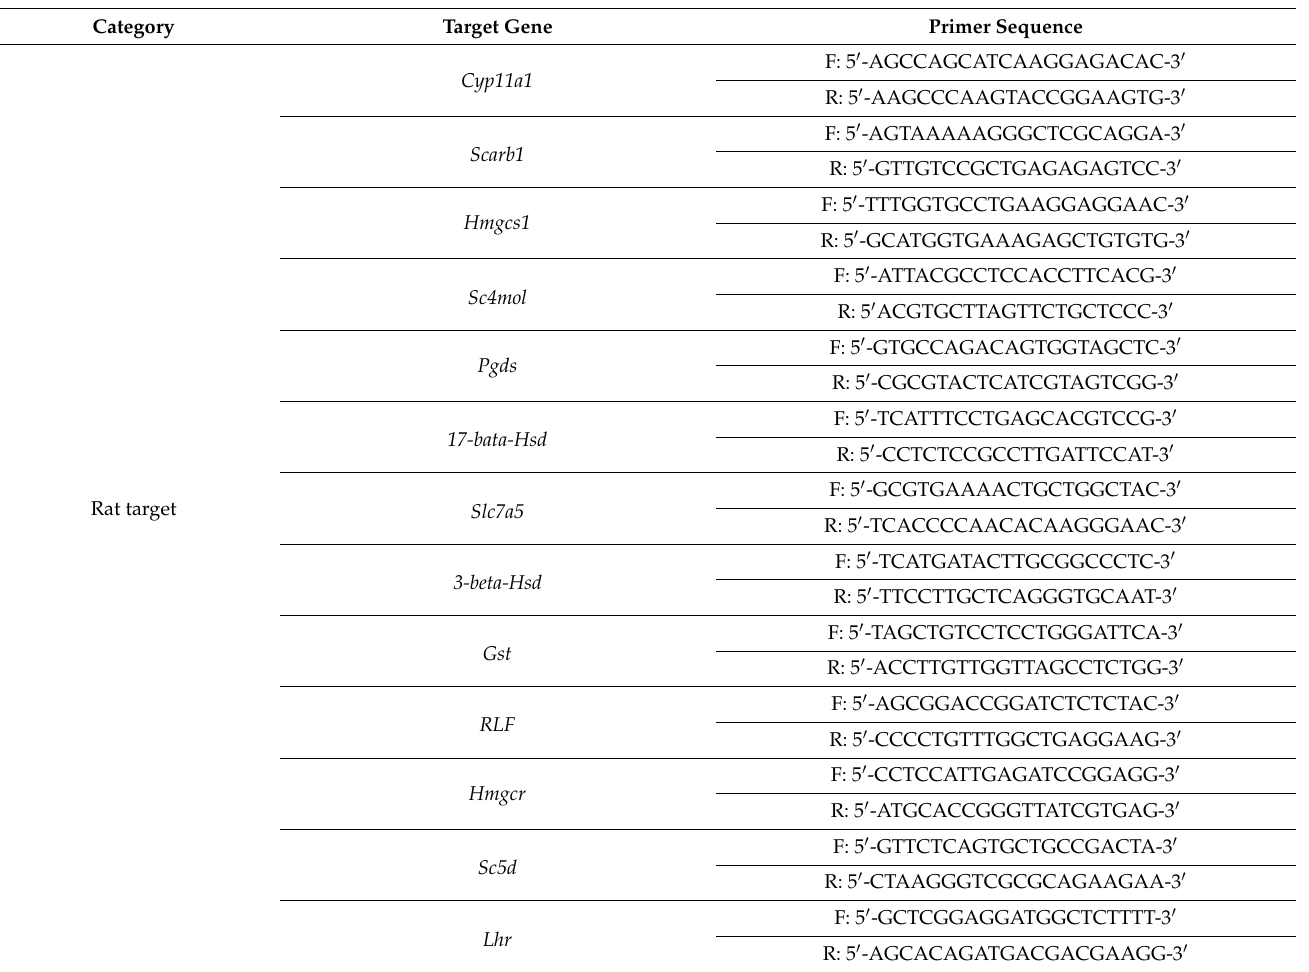
Table A2. List of primers used for quantification of mRNA